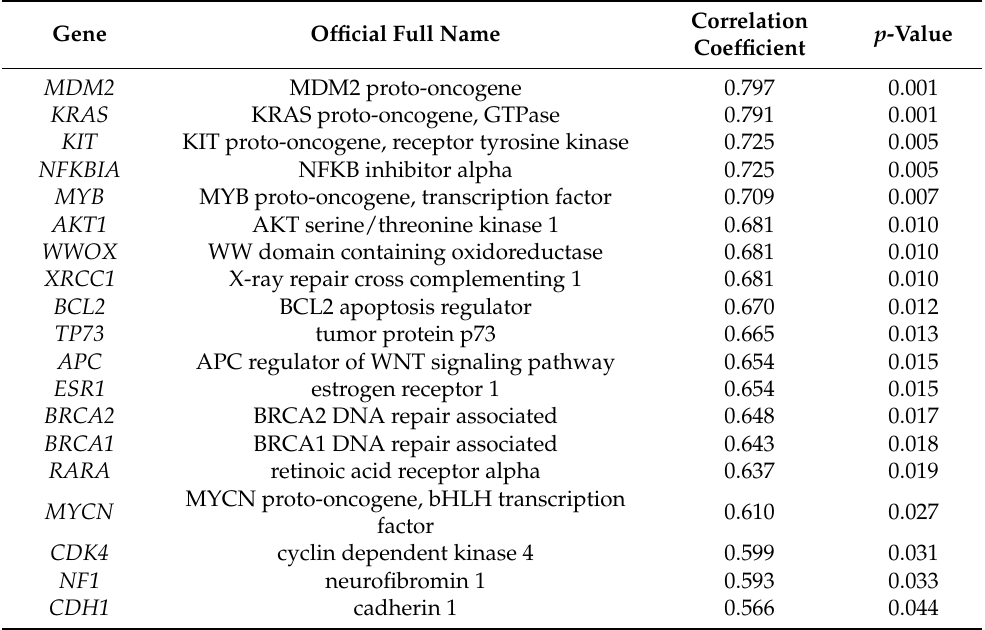
Table 1. Correlations between mRNA expression levels of SYT13 and cancer-related